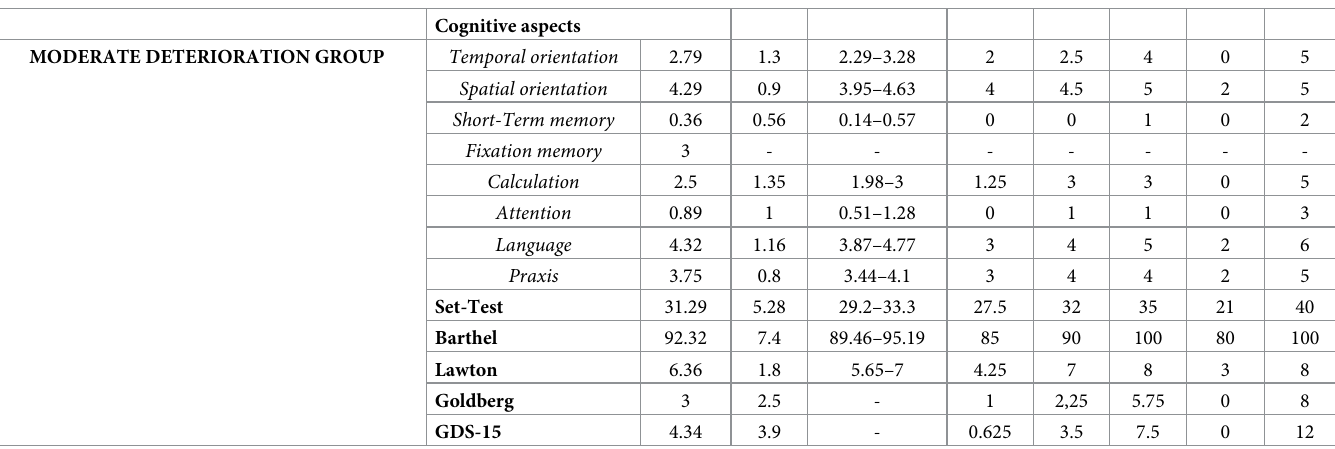
Table 5 shows the regression models for the prediction of the MEC-35, S-T, Barthel, and Lawton variables, in terms of TO, SO, STM, C, A, L, P, Goldberg, and GDS-15 variables. The regression coefficients and their significance are shown in the table, and it is evident that all of the neuropsychological constructs participate in the MEC-35 prediction, while TO, SO, STM, C, and P take part in the S-T prediction. In Barthel’s prediction, the variables L, P, and GDS-15 are significant, and we can highlight the last negative coefficients. Finally, the predictive model for L-B is significant through the linear combination of TO, STM, and Goldberg variables.